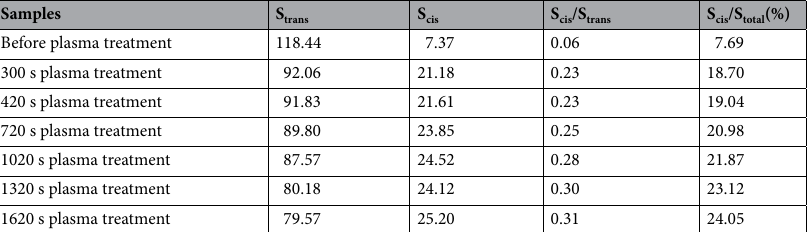
Table 1. The amounts of DR1 dye isomeric species and their ratios calculated from fitted double peaks before and after plasma treatment at different time intervals for dye-doped PMMA. S trans area under the fitted peak 1, S cis area under the right fitted peak 2, S total area under the cumulative fit peak.